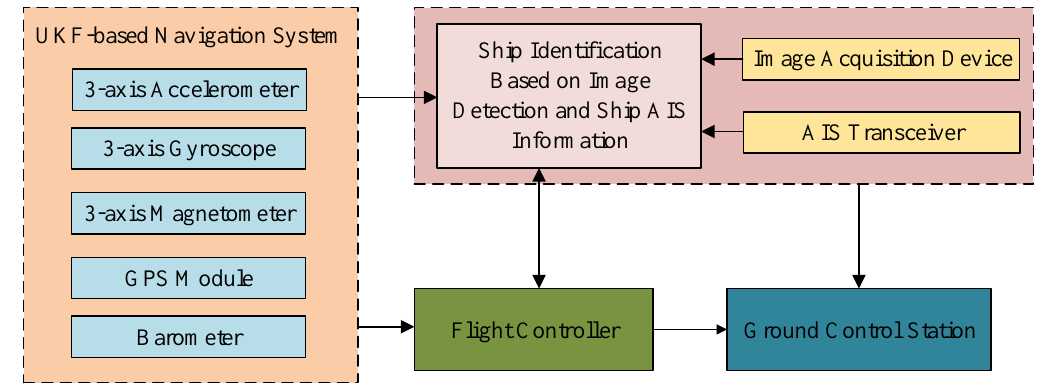
Figure 3. The hardware architecture of the Mar-UAV.